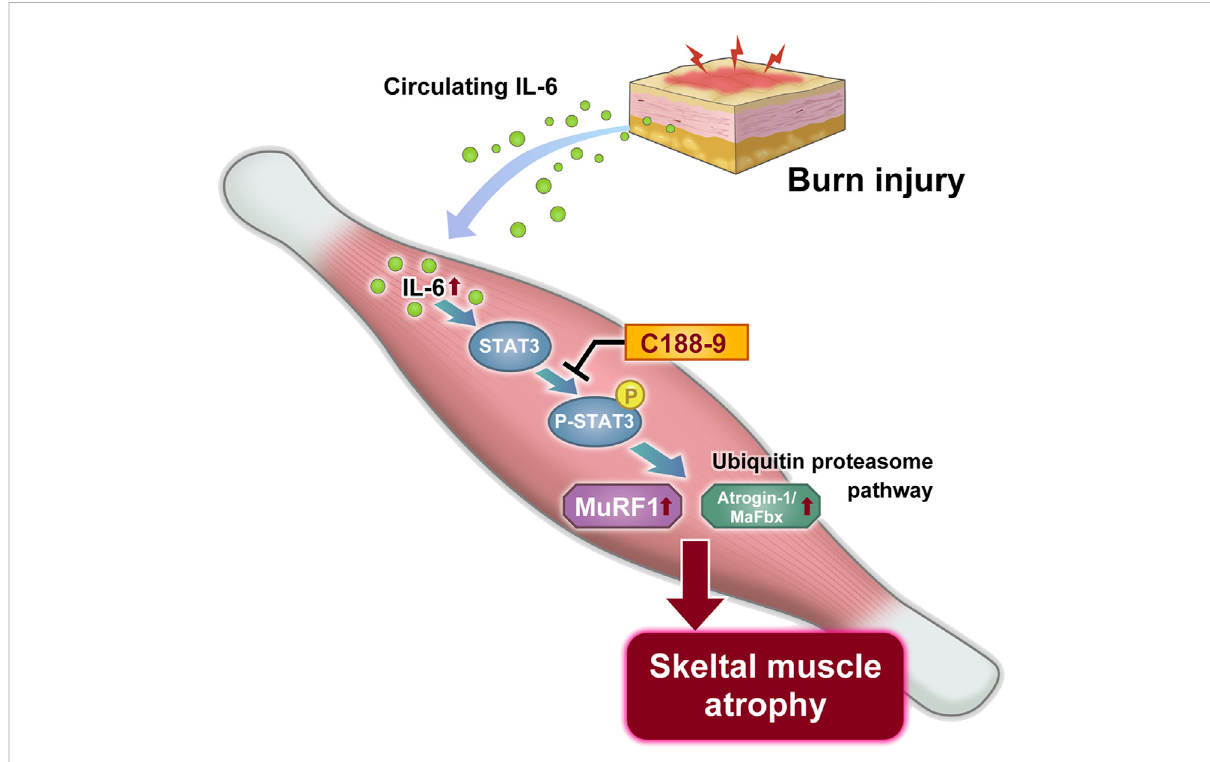
FIGURE 7 Proposed mechanism of thermal burn injury-induced skeletal muscle